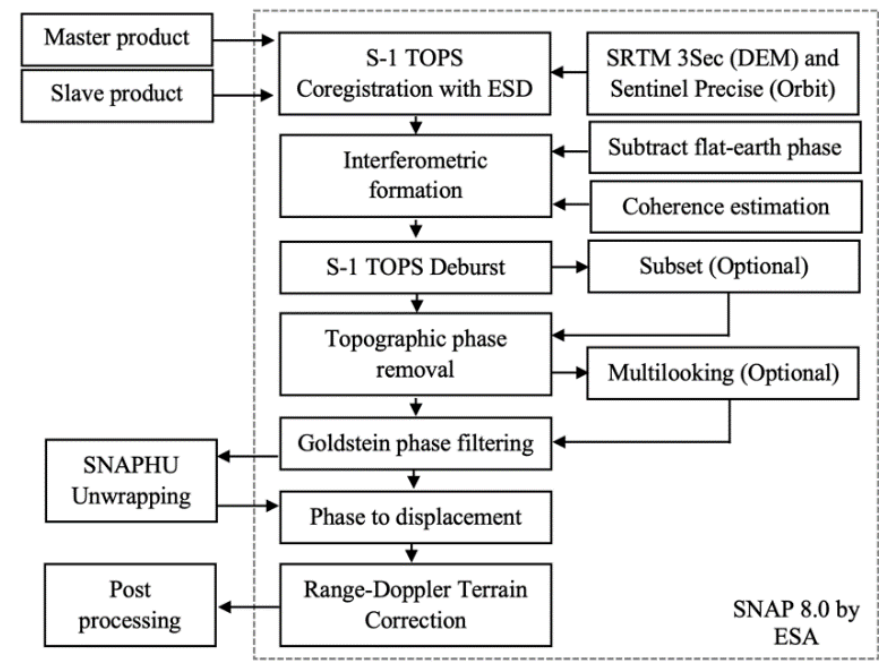
Figure 3. Standard differential InSAR (DInSAR) workflow using SNAP.